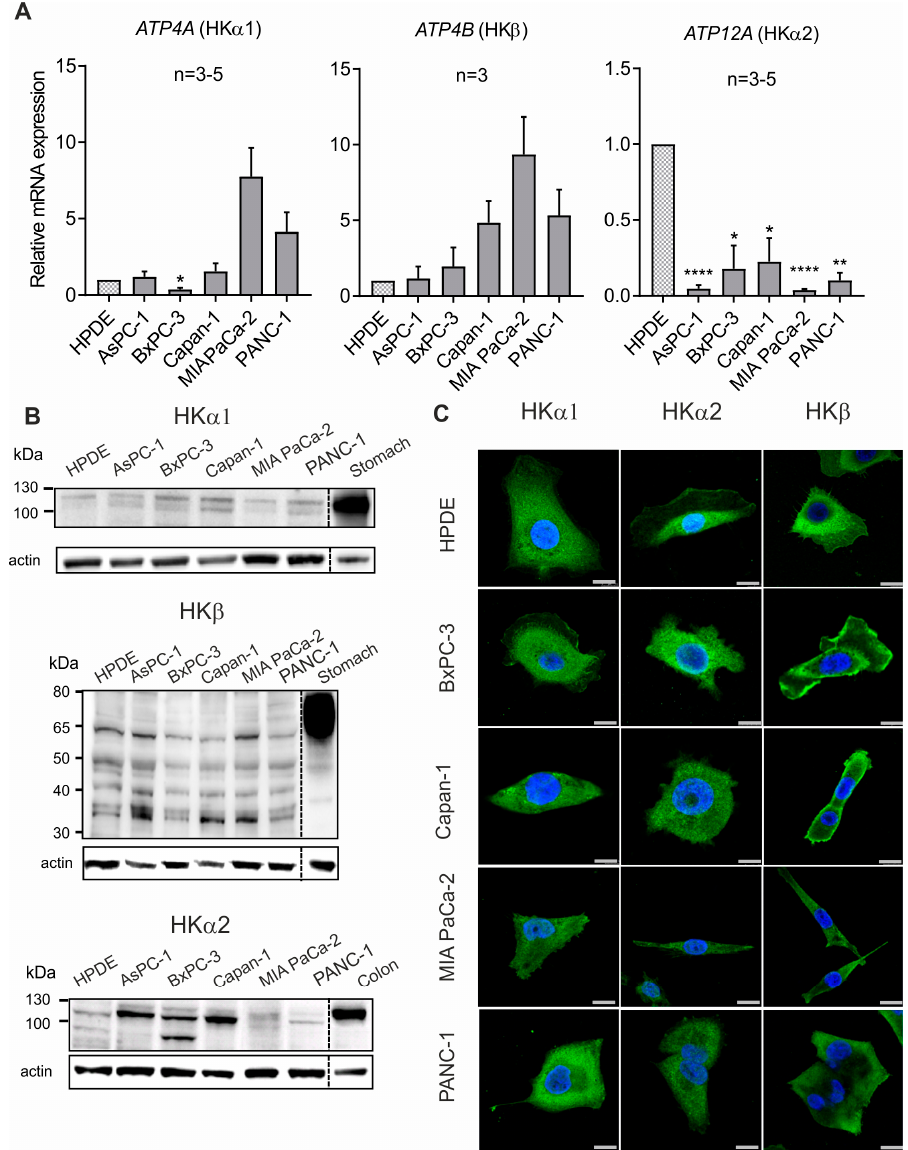
Figure 3. Expression of H + , K + -ATPase subunits HK α 1, HK α 2 and HK β in human pancreatic duct cell lines. ( A ) Quantitative RT-PCR showing the mRNA expression of the three subunits relative to HPDE. Data are shown as means ± s.e.m. from indicated number of independent experiments. One-sample t-test with Holm-Bonferroni correction was used for statistic: ATP4A : * p = 0.0145, ATP12A : **** p < 0.0001; ** p = 0.0012 and * p = 0.0116 and 0.0151. Unadjusted p value for ATP4B in PANC-1 and MIA PaCa2 were 0.0473 and 0.0280. ( B ) Representative Western blot for HK α 1 subunit (Abcam line HPDE, and PDAC cell lines AsPC-1, BxPC-3, Capan-1, MIA PaCa-2 and PANC-1, as well as control tissues (mouse stomach and colon). Loading control was β -actin. ( C ) Immunolocalization of HK α 1 (Calbiochem 119101, 1:100), HK α 2 (C384-M79, 1:300) and HK β (Sigma A274, 1:100) is reported in green. DAPI (blue) was used to stain the nuclei. Scale bars indicate 25 µ